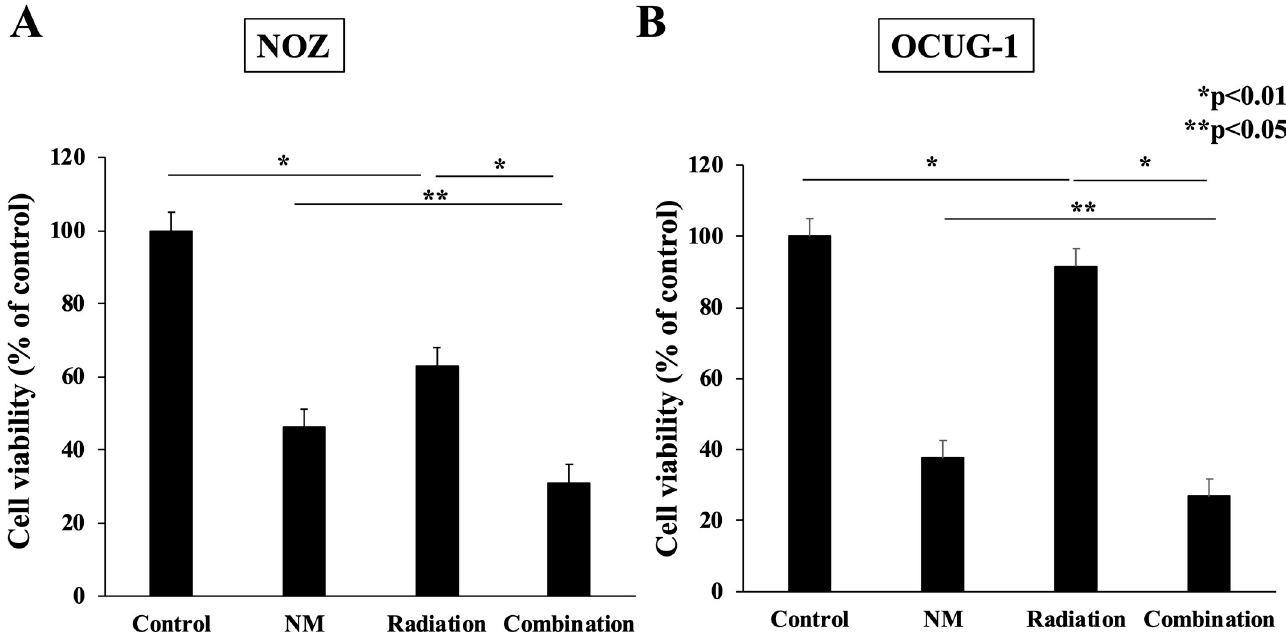
Fig 6. Cell proliferation evaluated using WST-1 assay. Cell viability in the combination group was suppressed compared with that in the radiation group for NOZ and OCUG-1 cells (NOZ: 31.1 ± 6.5% vs. 63.0 ± 4.0%, p < 0.01; OCUG-1: 26.8 ± 5.5% vs. 91.6 ± 2.2%, p < 0.01).